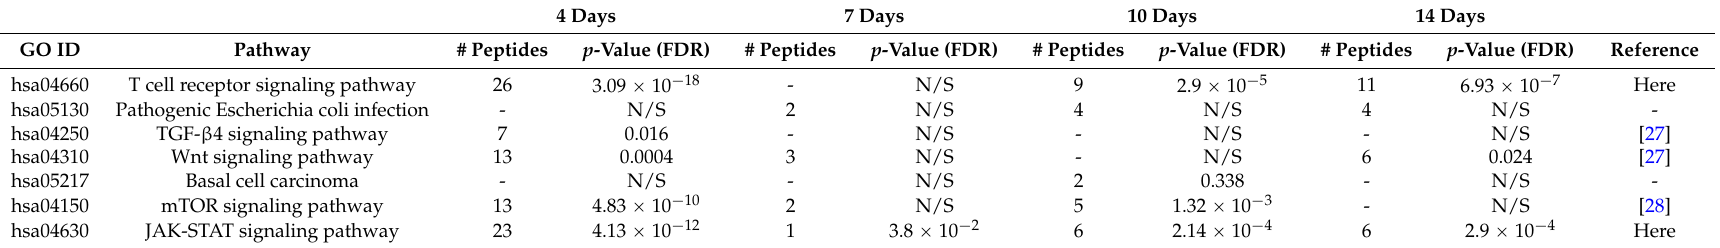
Table 3. KEGG Pathways generated by Search Tool for the Retrieval of Interacting Genes/Proteins (STRING).